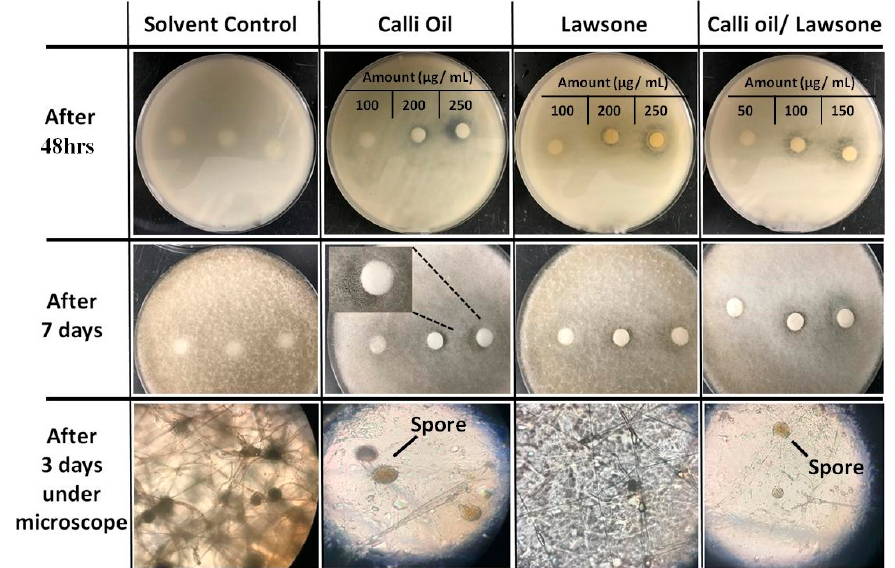
Figure 5. The antifungal effect of lawsone, Calli oil and combined Calli oil/lawsone on R. delemar , a spore-forming fungus at different concentrations. The effect was measured visually by disc diffusion assay and under light microscope. The experiment was repeated at least three